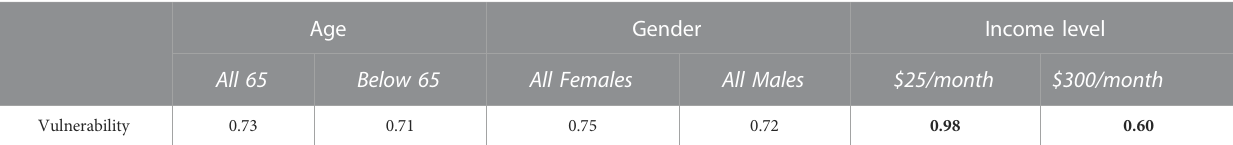
TABLE 5 Sensitivity of Vulnerability for Age, Income, and Gender at the extreme vulnerability